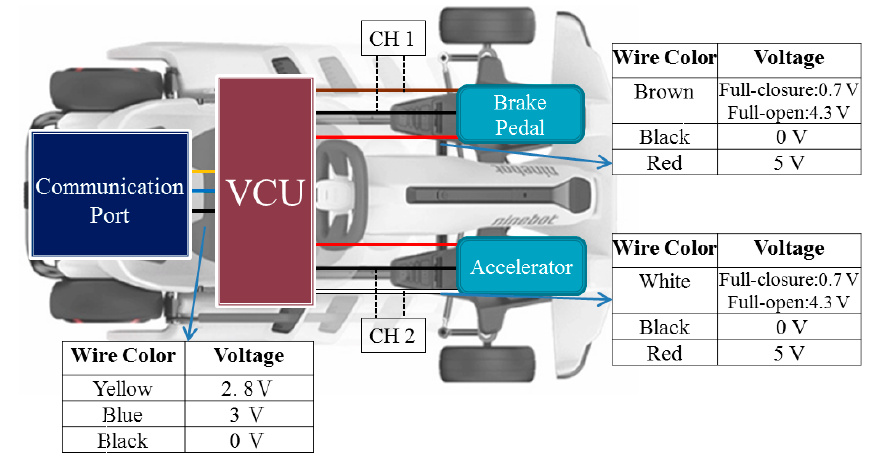
Figure 2. The schematic configuration of the acceleration/brake-by-wire system.